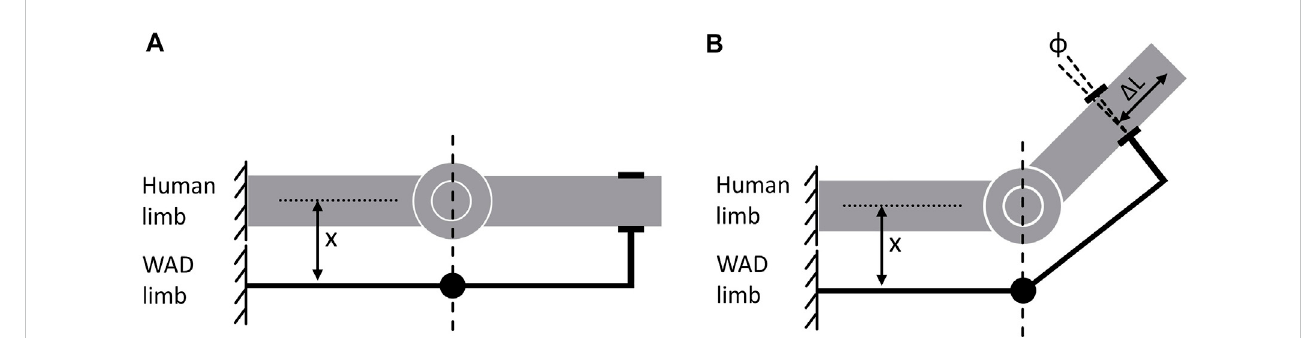
FIGURE 1 Misalignment shown on a simple degree of freedom joint attached with a WAD based on (Schiele and van der Helm, 2006); (A) initial aligment of human limb and WAD limb, (B) Occurring relative motion between human limb and WAD limb due to movement of the single degree of freedom joint of the human